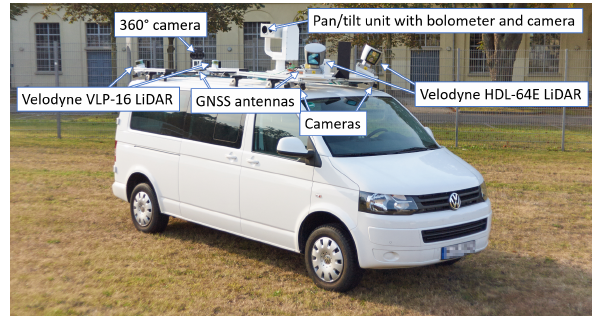
Figure 4. Measurement vehicle MODISSA. Equipped with several sensors including four LiDAR